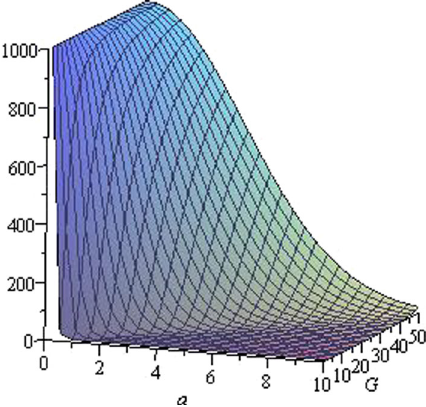
Fig. 9 Represents wave function with respect to the scale factor